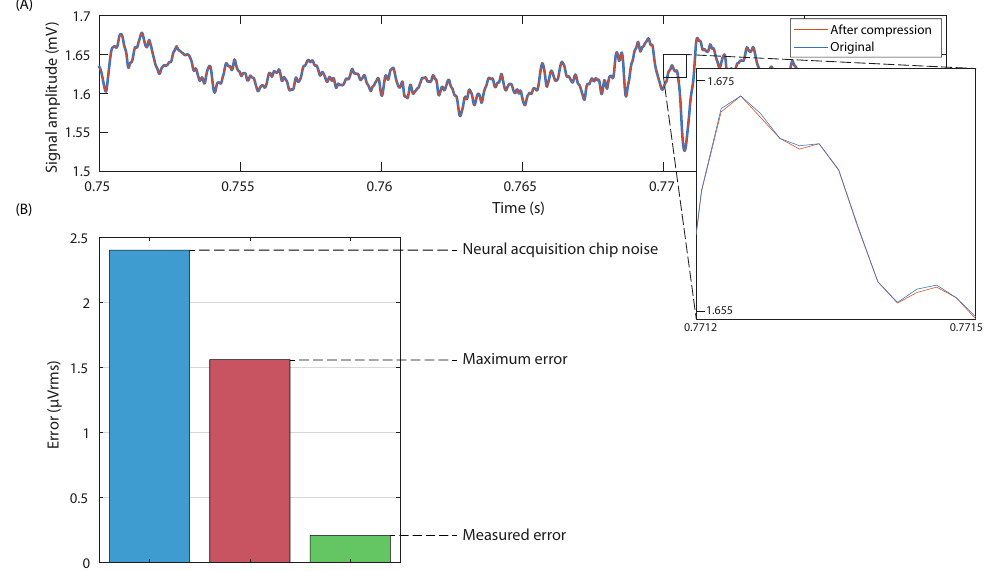
Figure 7. Effect of compression on signal integrity. ( A ) Compressed and original signals. The error is indistinguishable without magnification. ( B ) Error introduced by the algorithm compared with the acquisition chip noise floor.